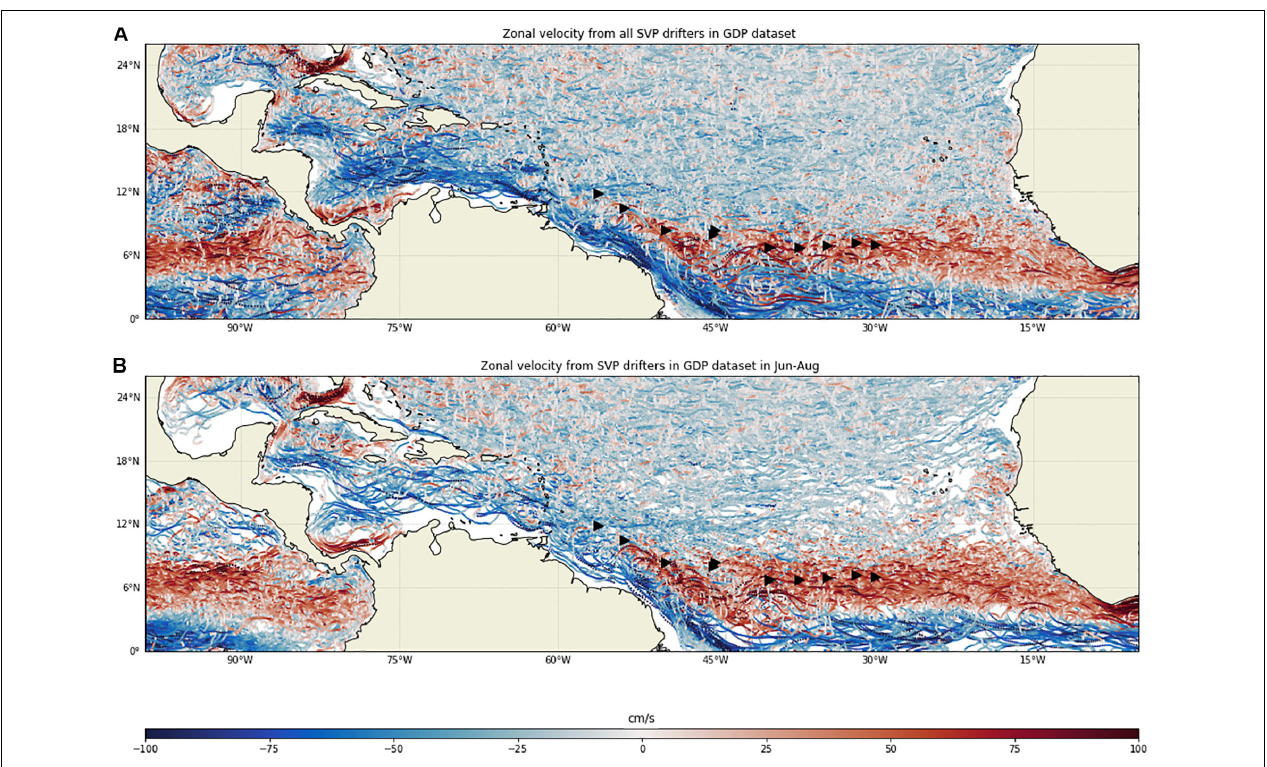
FIGURE 4 | Maps depicting the zonal velocity (in cm/s) for all the SVP drifters in NOAA’s Global Drifter Program six-hourly dataset. Panel (A) shows the velocities for all SVPs, panel (B) shows the velocities for only these SVPs that were reporting in June, July, or August. Black triangles depict the launch locations of our drifters in July 2019.